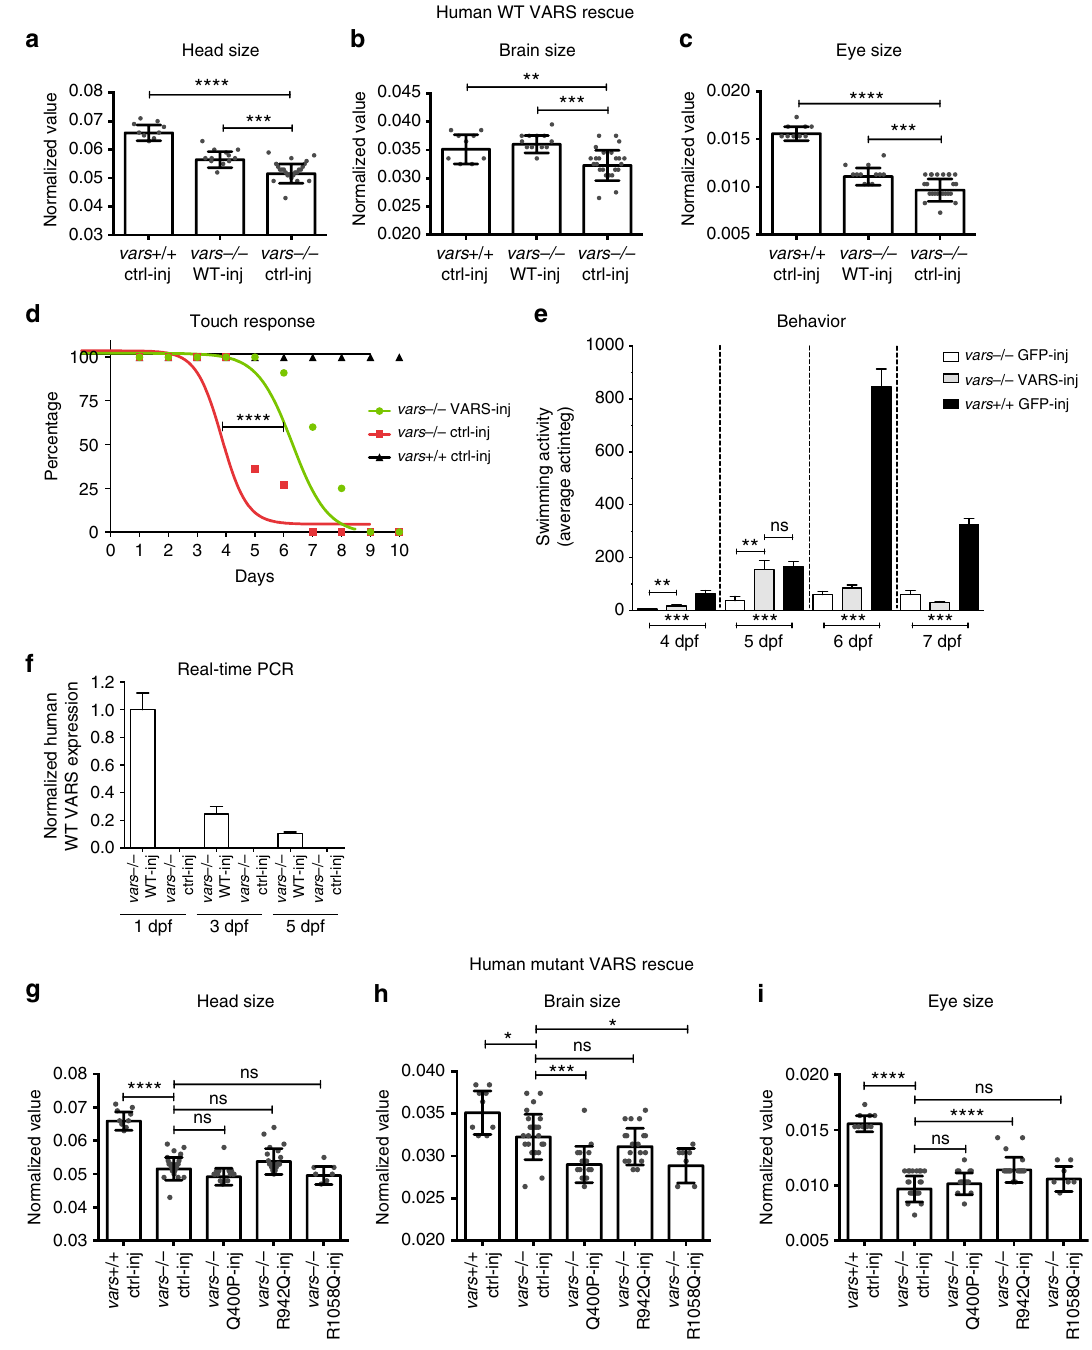
Fig. 5 Wild-type human VARS mRNA partially rescues early zebra fi sh phenotype, whereas mutated constructs do not. a – c Comparison of the individual measurements for head size a , brain size b , and eye size c for WT human VARS-injected vars − / − larvae ( n = 12). GFP-injected vars + / + larvae ( n = 9) were used as a positive control, whereas GFP-injected vars − / − larvae ( n = 24) served as a negative control. Values are mean of three separate experiments. d Curves illustrating the evolution of touch response during the life span of vars − / − larvae injected with WT human VARS ( n = 12) and GFP mRNA ( n = 11) (negative control). vars − / − GFP-injected larvae were used as a positive control. e Average total movement of WT human VARS- injected ( n = 10) and GFP - injected ( n = 9) vars − / − larvae from 3 to 7 dpf. vars + / + GFP - injected larvae ( n = 14) were used as a control. f RT-qPCR data demonstrating expression levels of injected human WT VARS in vars − / − larvae at 1, 3, and 5 dpf. At 3 and 5 dpf there was 24.55% and 10.42% WT VARS mRNA left, respectively, in comparison to 1 dpf. Values are mean of three separate experiments performed in triplicate. g – i Comparison of the individual measurements for head size g , brain size h , and eye size i for human mutated Q400P ( n = 15), R942Q ( n = 18) and R1058Q ( n = 7) VARS-injected vars − / − larvae. GFP-injected WT larvae ( n = 9) were used as a positive control, whereas GFP-injected vars − / − larvae ( n = 24) served as a negative control. Values are mean of three separate experiments. In a – c and g – i one-way ANOVA with Tukey ’ s multiple comparisons test was used; in d — log-rank (Mantel- Cox) test; in e — unpaired t -test. Signi fi cant values are noted * p < 0.05, ** p < 0.01, *** p < 0.001, and **** p < 0.0001. Error bars represent